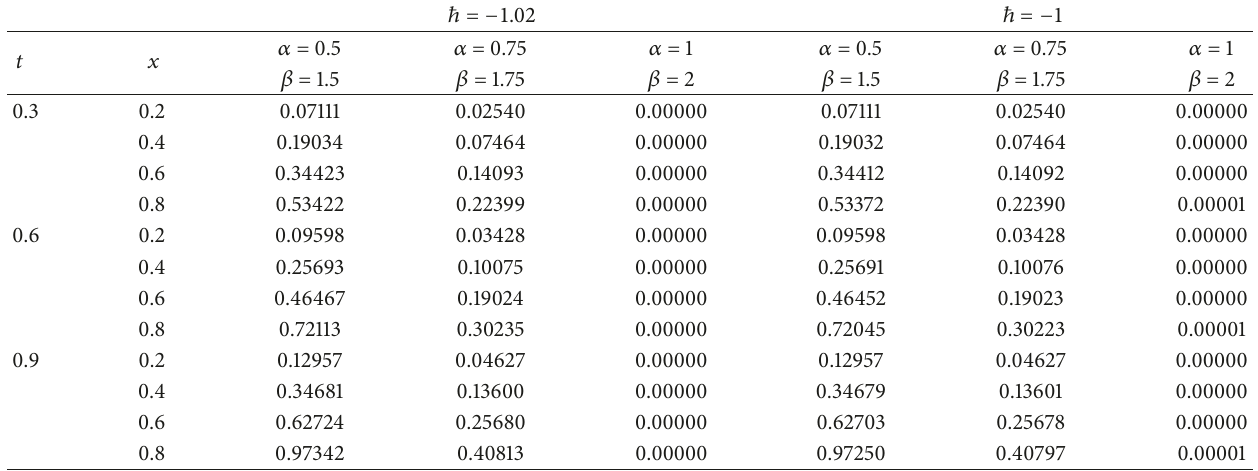
Table 2: The absolute errors for case B in Example